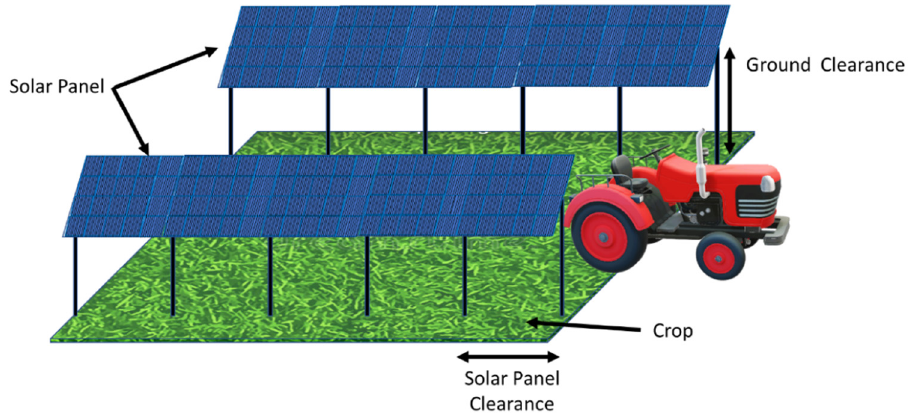
Figure 8. Solar agriculture farm where solar panels are co-located with crops.